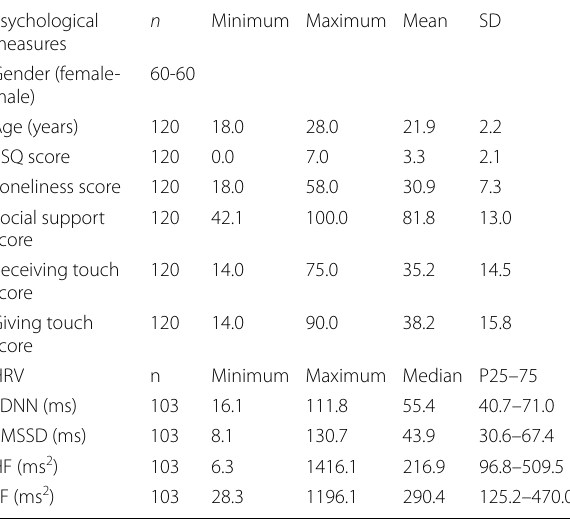
Table 1 Descriptive statistics for psychosocial measures and